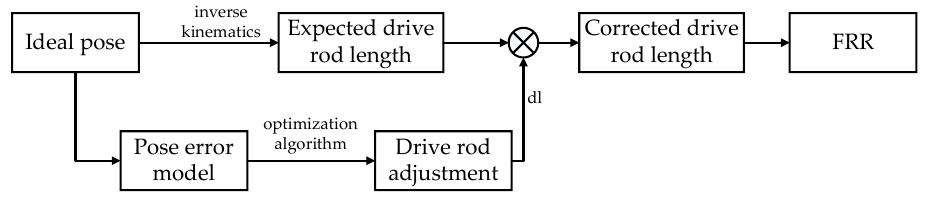
Figure 7. FRR error compensation block diagram.